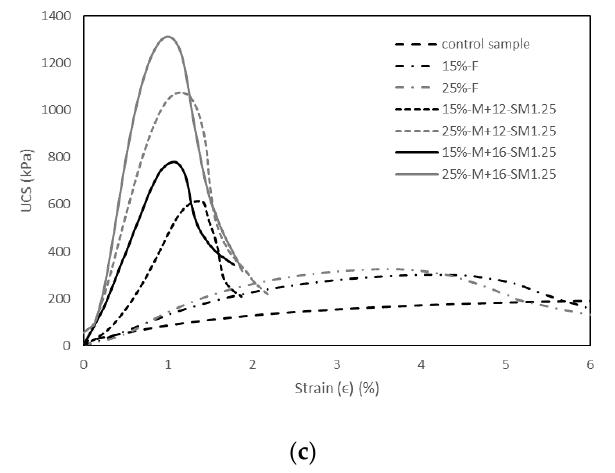
Figure 8. Stress-strain behaviour of the control sample, soils stabilised with 15% and 25% of fly ash, and soils stabilised with 15% and 25% of alkali-activated fly ash with a constant SM of 1.25 and an M+ of 12% or 16% at different curing times: ( a ) 1 day of curing; ( b ) 7 days of curing; ( c ) 28 days of curing.